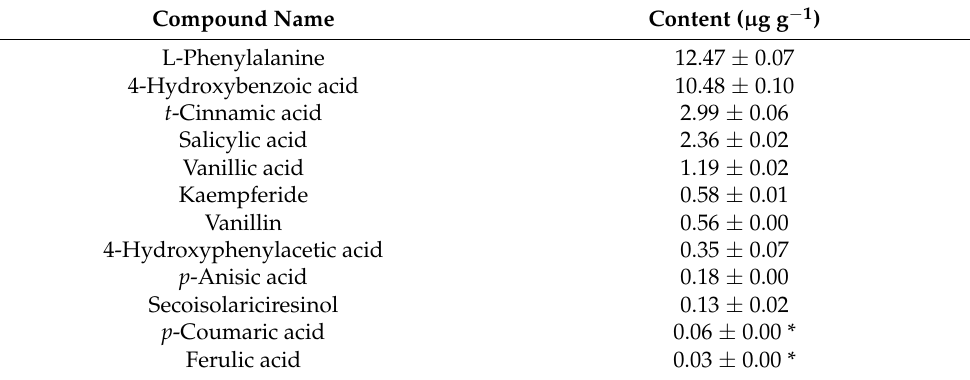
Table 1. Phenolic compounds identified and quantified in methanolic extract from C. nocturnum